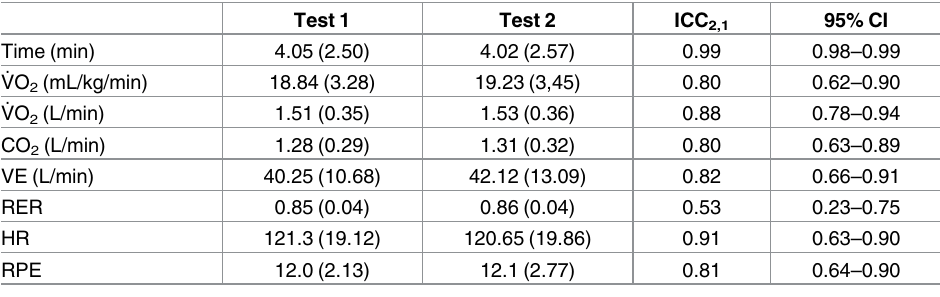
Table 3. Reliability measuresfor the field-test (n =